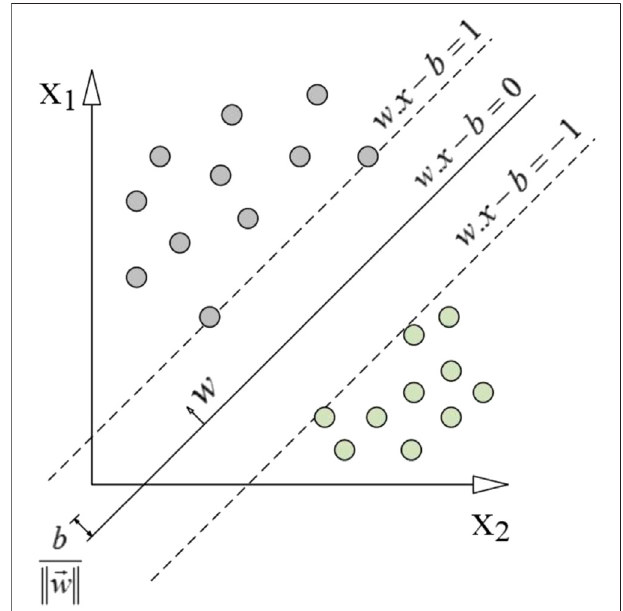
FIGURE 4 | Maximum margin hyperplane for a support